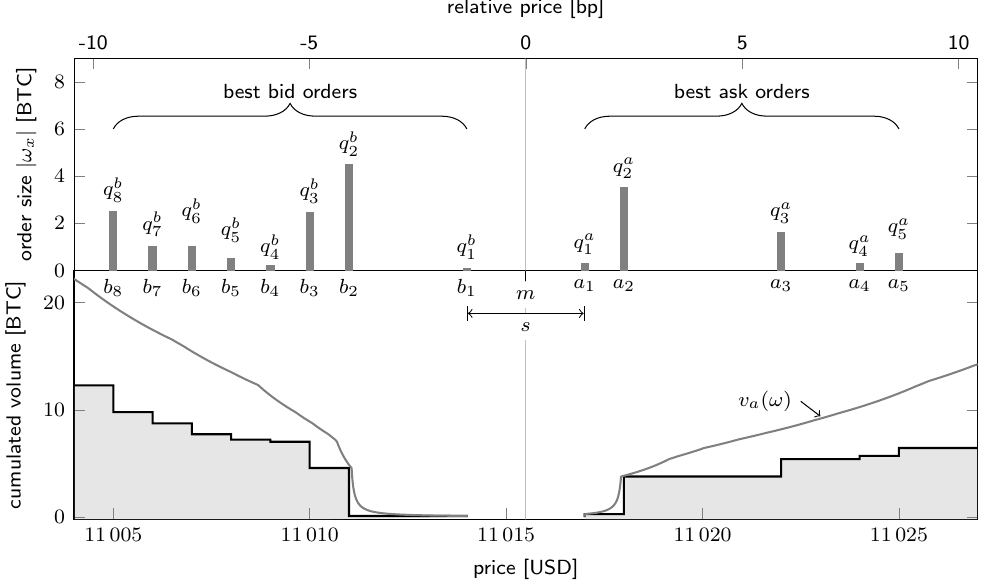
Figure 1. Schematic visualization of a limit order book. The figure visualizes the order book state L ( t ) for the BitFinex BTC/USD market as of 2 December 2017 22:01:26